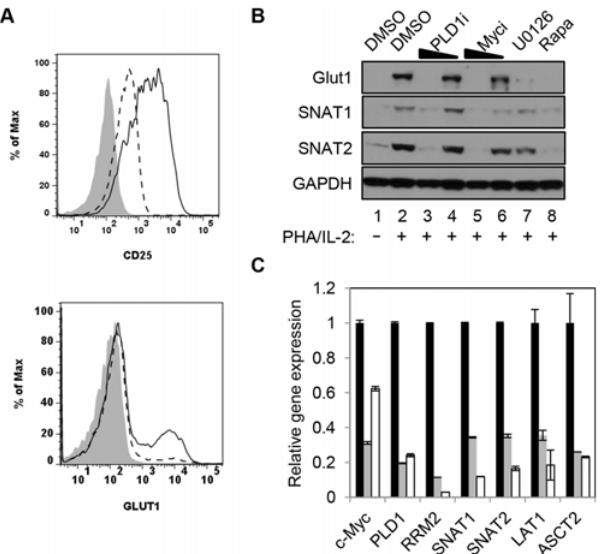
Fig 2. PLD1 activity is required for normal expression of nutrient transporters in activated T cells. (A) Cell surface expression of glucose transporter Glut1 and activation marker CD25 as determined by flow cytometry on resting primary CD4+ T cells (shaded histogram) or after stimulation with anti-CD3/anti-CD28 beads for 48h in the absence (solid line) or presence of PLD1i (dashed line). (B) Western blot analysis of protein expression in whole cell lysates from primary CD4+ T cells treated as in Fig 1A. (C) Q PCR analysis of expression of target genes in primary CD4+ T cells nucleofected with siRNA and then stimulated for 24 h as in Fig 1C. T cells were nucleofected with non-targeting (NT) (black bars), c-Myc (grey bars), or PLD1 (open bars)- specific siRNAs. mRNA abundance in NT siRNA sample was set to1. Error bars represent standard error from the mean of triplicate samples. Data are representative of experiments from three independent